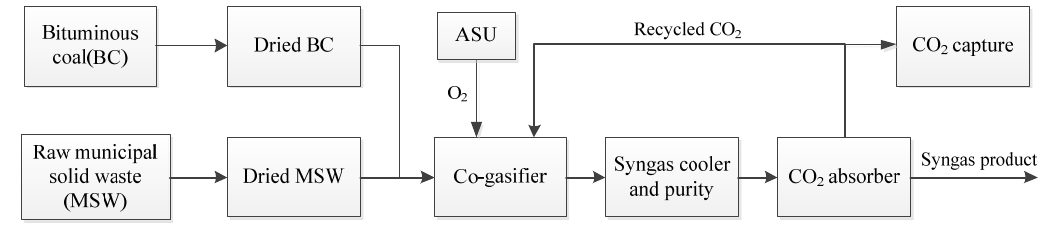
Figure 1. The schematic of the MSW / BC co-gasification system in CO 2 / O 2 atmosphere.